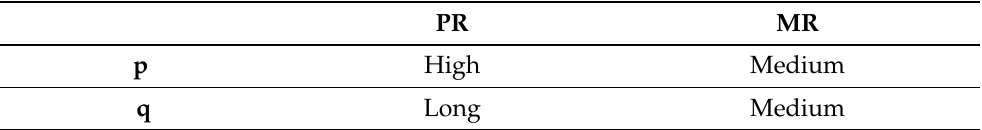
Table 2. Energy ( p ) and Latency ( q ) for each routing mechanism of the 2 × 2 game.